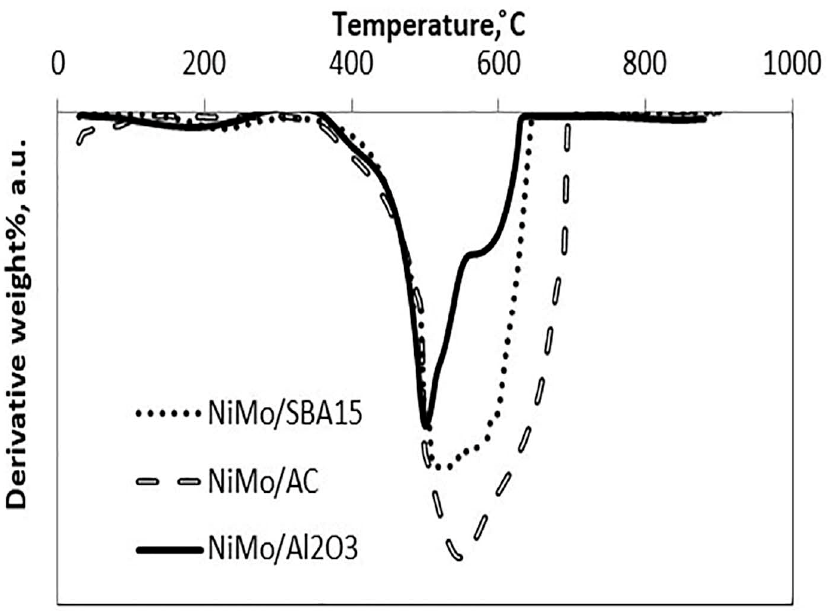
Figure 8. Derivative of thermogravimetric (DTG) curves of spent catalysts.